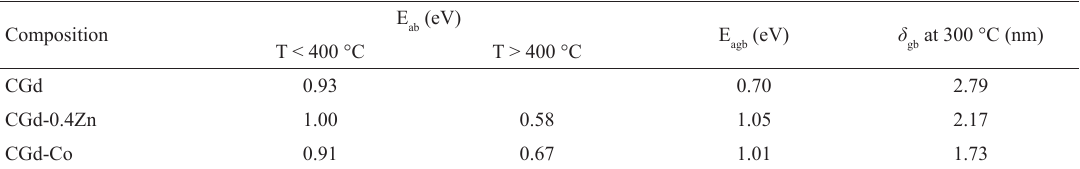
) conductivities, grain boundary thickness ( δ agb